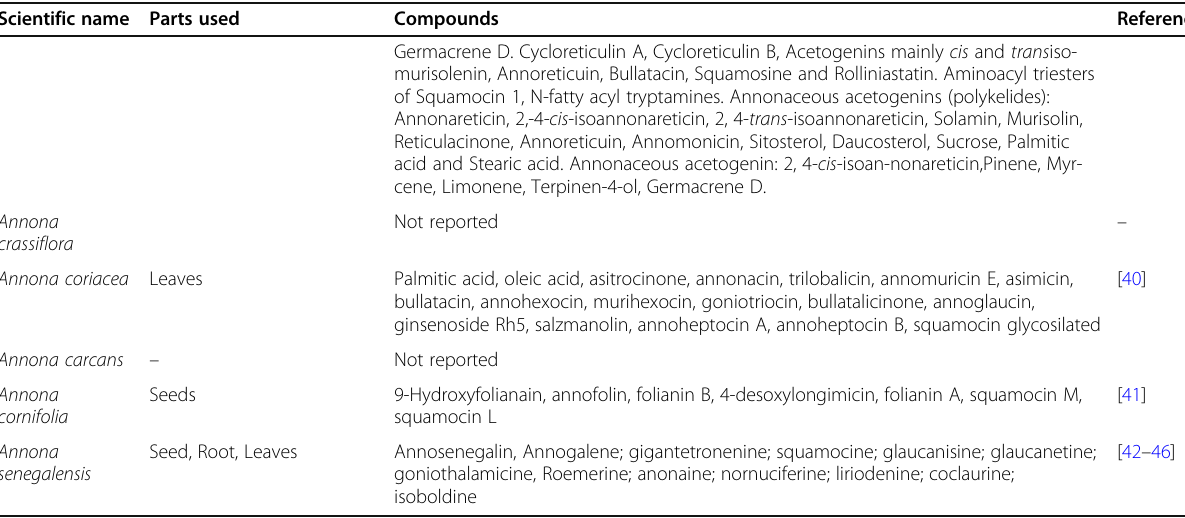
Table 2 Phytochemical constituents of the species